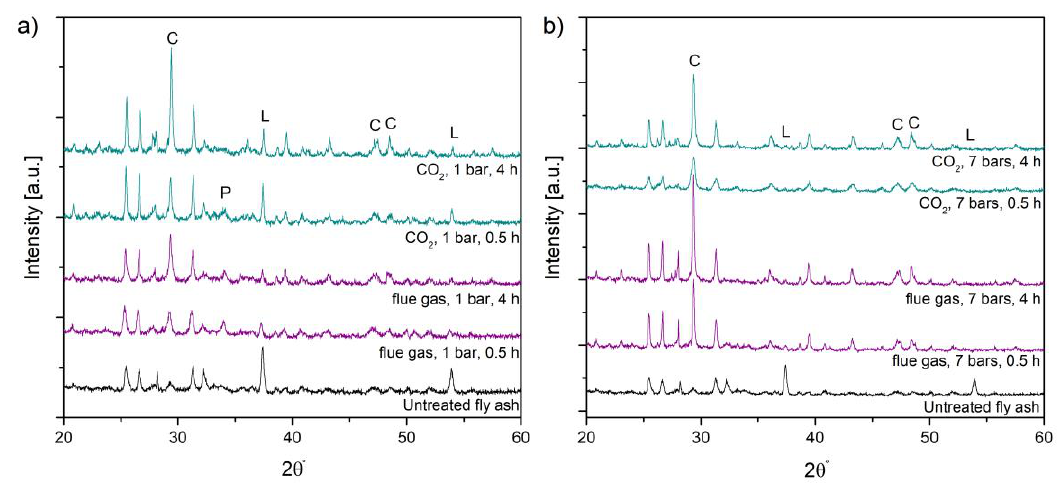
Figure 1. XRD analysis of fly ash carbonated using concentrated CO 2 and flue gas over 0.5 and 4 h at ( a ) atmospheric and ( b ) 7 bars pressure. C—calcite, L—lime, P—portlandite. ash occurs